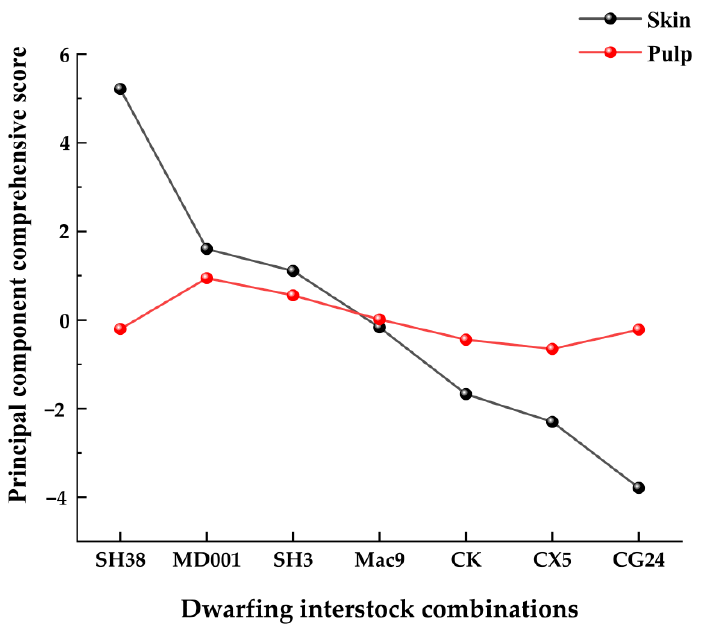
Figure 4. Principal component comprehensive score for the skin (black) and pulp (red) of ‘Huahong’ apples grown from different dwarf interstock combinations.